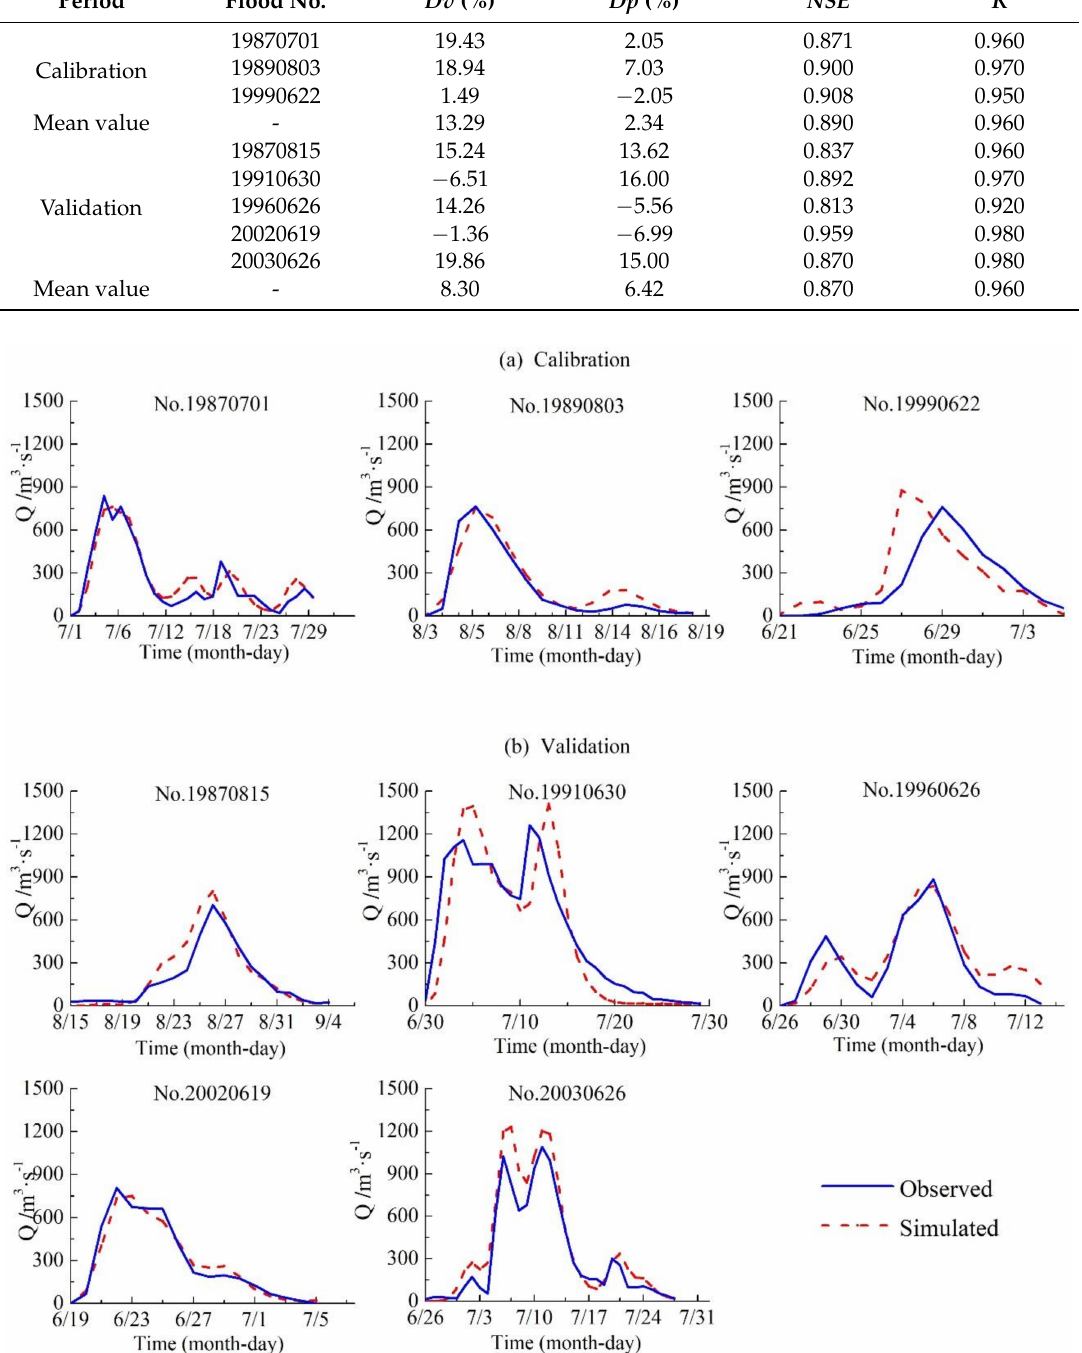
Figure 3. Comparison of simulated and observed hydrographs for the selected eight flood events ( a ) calibration period, ( b ) validation